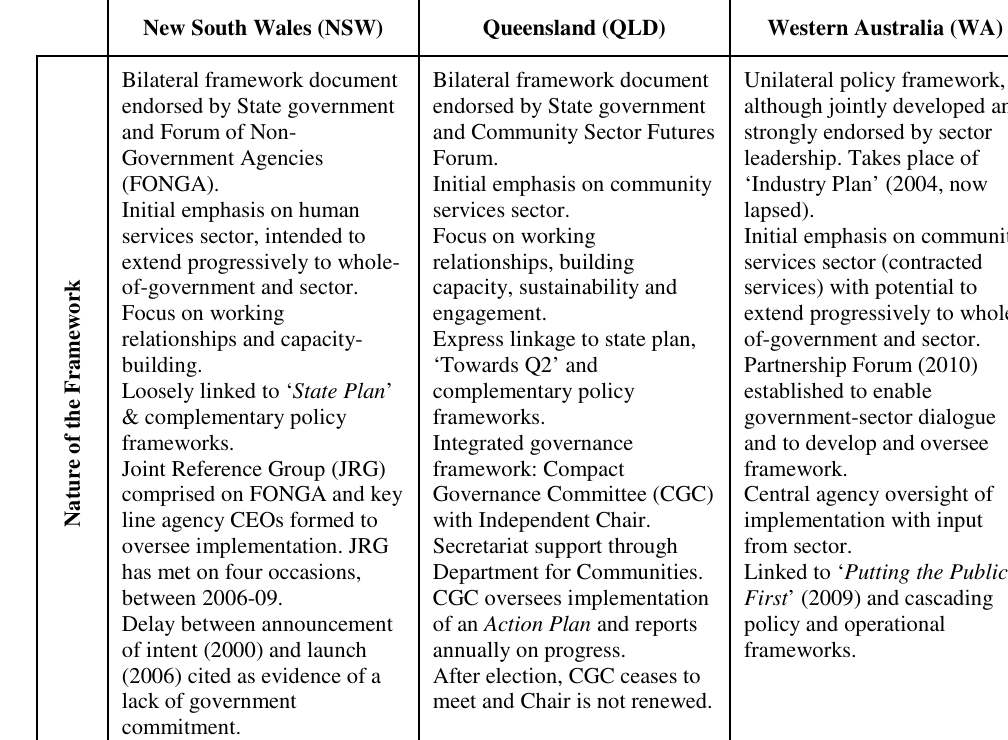
Table 3 — A Comparison of Frameworks for Inter-sectoral Cooperation in Selected Australian States: Framework, Impacts & Future